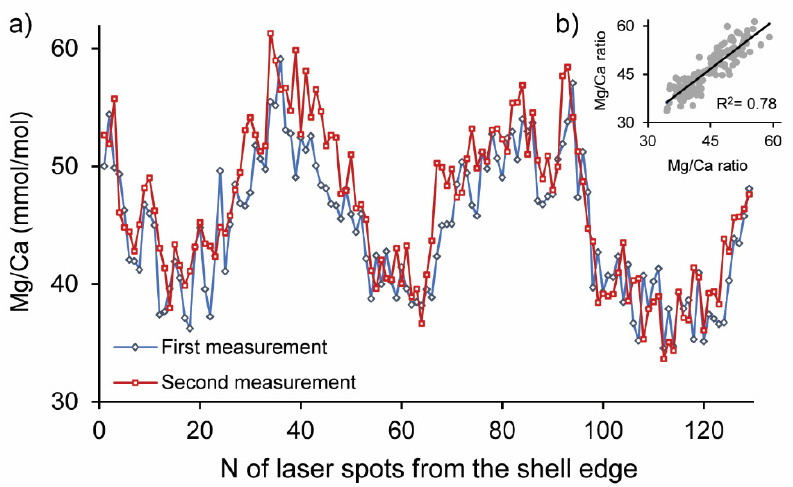
Figure 7. ( a ) Two Mg/Ca ratio series obtained from a limpet cross-section measured on limpet LAN545 along the same path and ( b ) the correlation between both